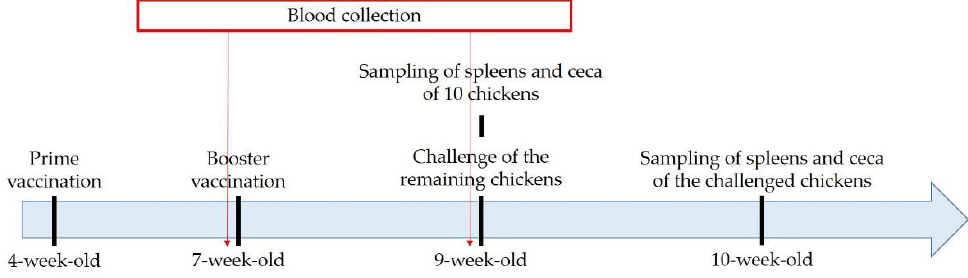
Figure 1. Experimental design diagram for evaluation of immune responses and protective efficacy of a vaccine candidate in